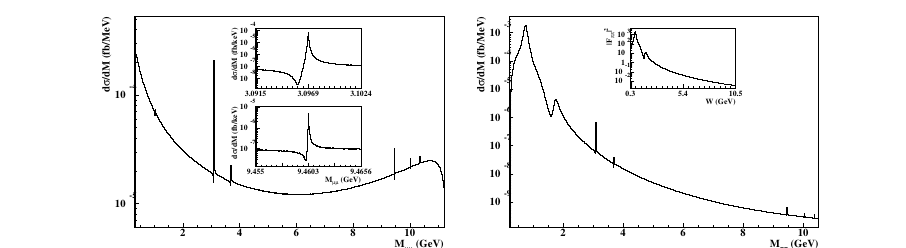
Figure 2. The cross section of e + e − → µ + µ − π + π − process as a function of the muon pair invariant mass (left) the pion pair invariant mass (right). The square of the pion form-factor is shown for comparison in the insertion on right.